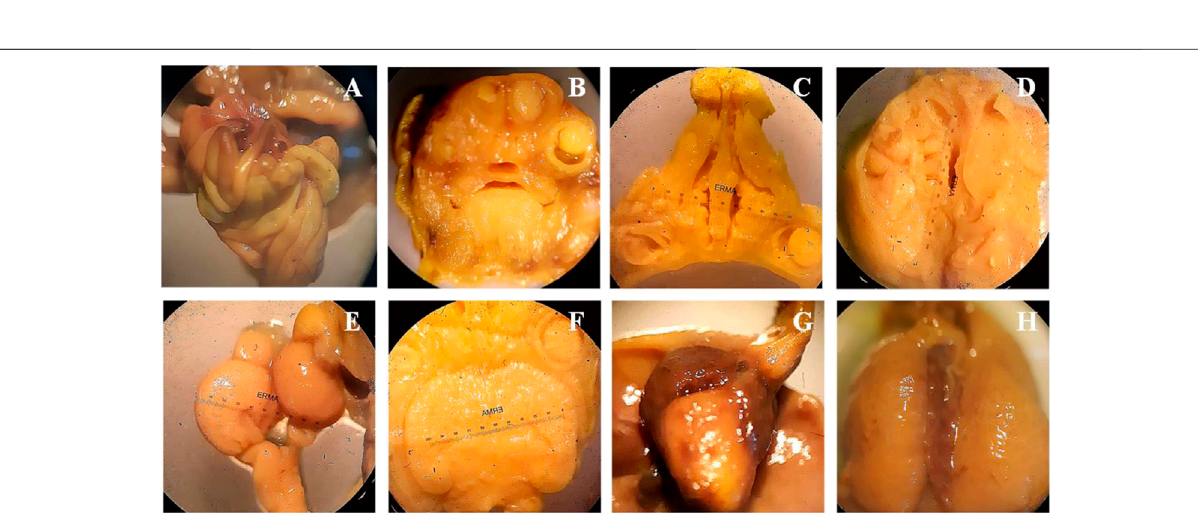
Frontiers in Pharmacology |